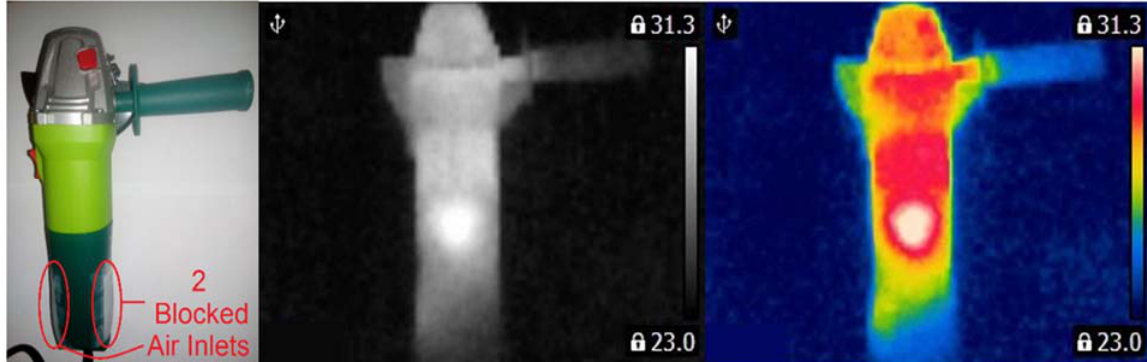
Figure 5. Angle grinder with 2 blocked air inlets.